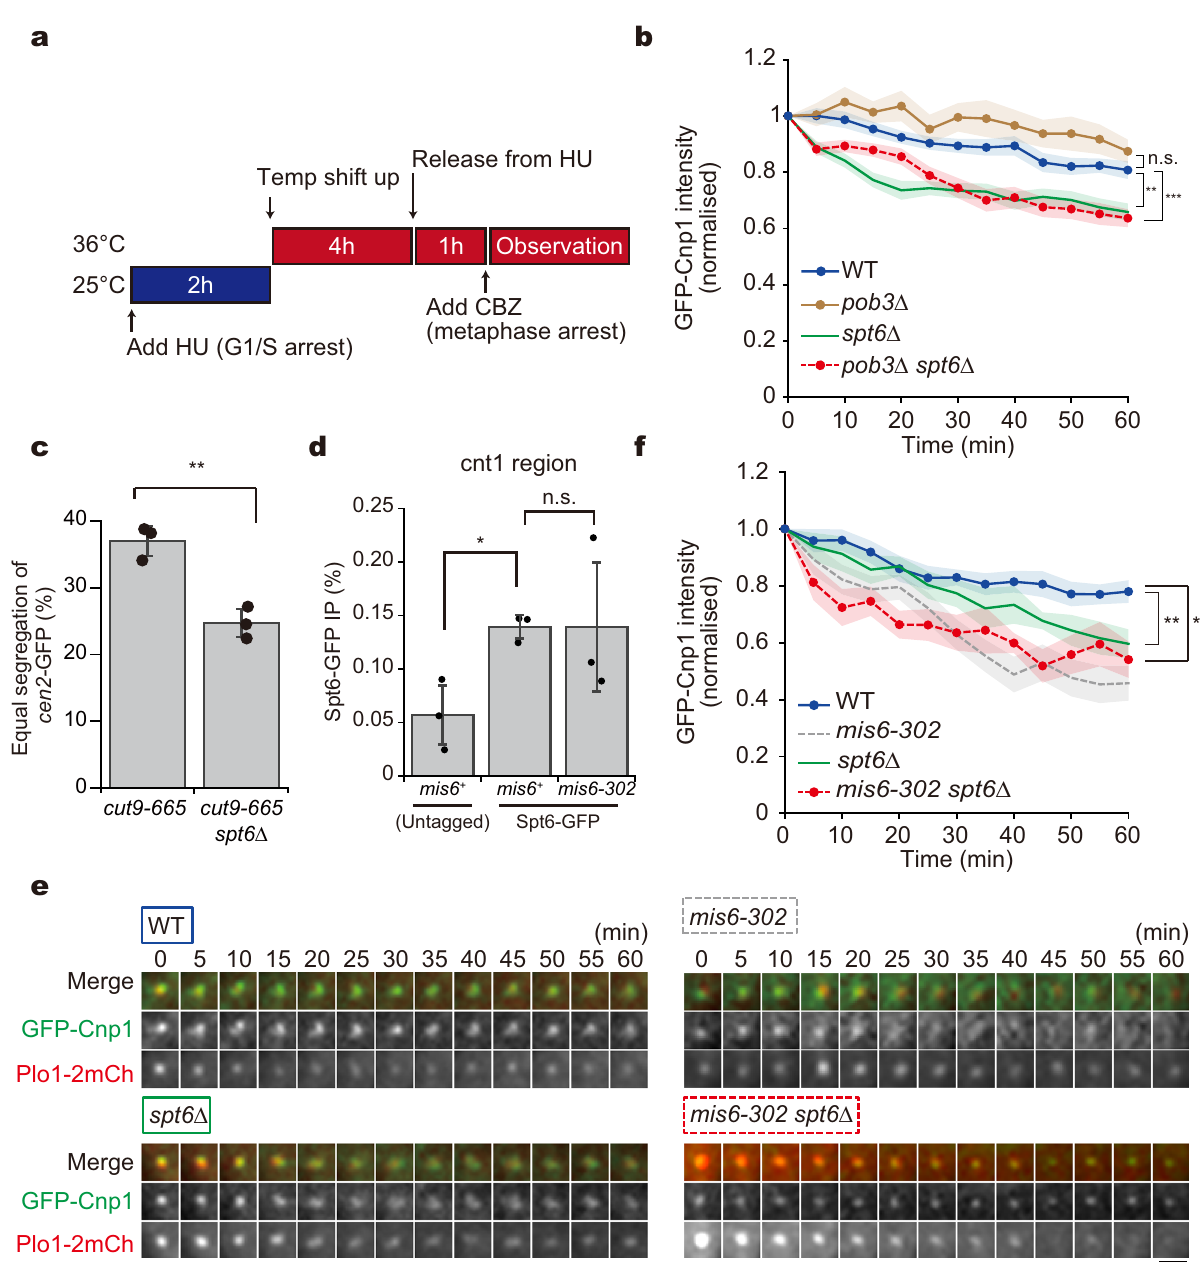
Fig. 5 Recycling of Cnp1 requires the chromatin remodelling factor Spt6. a , b Cnp1 maintenance assays during metaphase were performed using mutants of indicated chromatin remodellers. a Experimental design. Cells arrested to G1/S at 25 °C were shifted up to 36 °C to inactivate Alp12. Cells were then released into mitosis and arrested at metaphase via the microtubule poison carbendazim (CBZ) treatment prior to observation. b A Cnp1 maintenance assay. Temporal kinetics of GFP-Cnp1 fl uorescence intensity in metaphase were monitored for each mutant. WT (blue solid line), n = 18 cells; pob3 Δ (brown solid line), n = 14 cells; spt6 Δ (green solid line), n = 16 cells; pob3 Δ spt6 Δ (red dashed line), n = 35 cells. The data are normalised to intensities at 0 min. c Population of cells with equal segregation of cen2- GFP (chromosome II centromere was visualised with GFP). Error bars = ±s. d., N = 3 experiments. ** p < 0.01 (Welch ’ s t -test [two-tailed]). d ChIP of Spt6-GFP using at the cnt region in mis6 + and mis6-302 cells expressing Spt6-GFP or untagged Spt6. ChIP was performed with the anti-GFP antibody. Error bars = ±s. d., N = 3 experiments. * p < 0.05, n.s. p > 0.05 (Welch ’ s t -test). e , f Cnp1 maintenance assay. e Time-lapse images for cells expressing GFP-Cnp1 (green) and Plo1-2mCherry (red) for each mutant background. Scale bar = 2 µ m. f WT (blue solid line), n = 16 cells; mis6-302 (grey dashed line), n = 20 cells; spt6 Δ (green solid line), n = 14 cells; mis6-302 spt6 Δ (red dashed line), n = 11 cells. The data are normalised to intensities at 0 min, and used for WT and mis6-302 cells are identical to that in Fig. 2g. The solid and dashed lines indicate the mean value, and the coloured regions indicate the standard error (s.e.m.). *** p < 0.001, ** p < 0.01, n.s. p > 0.05 (Welch ’ s t